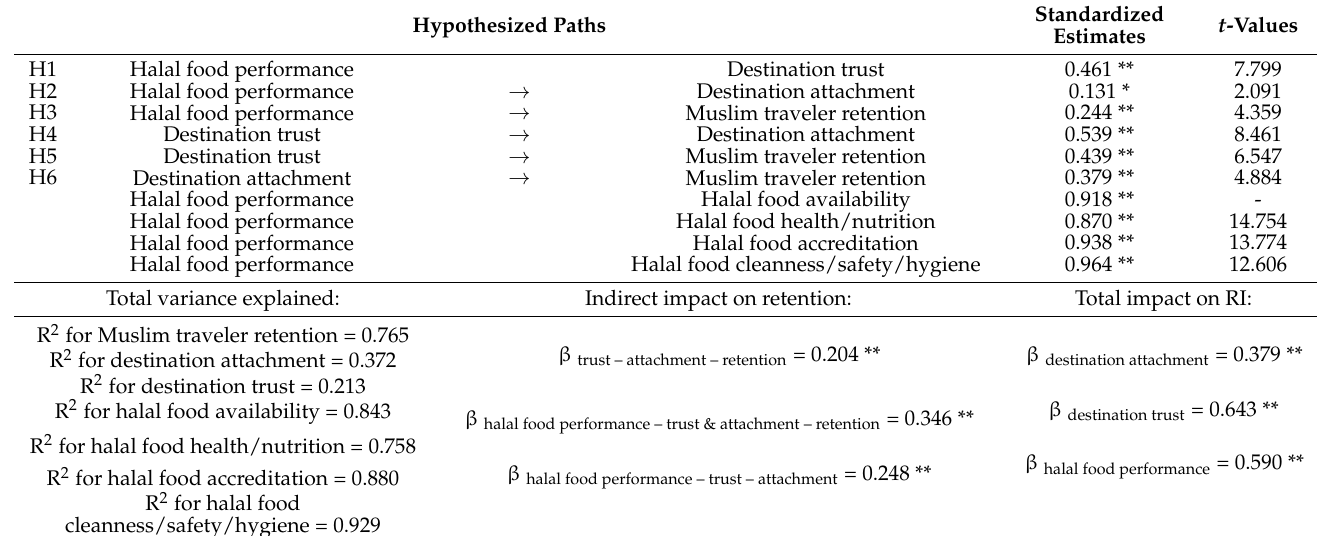
Table 3. Structural equation modeling results and hypotheses testing ( n = 326).